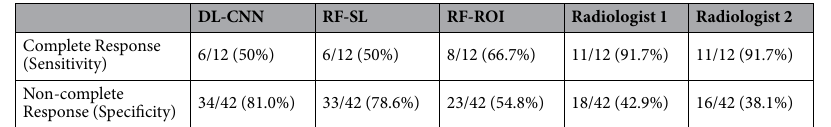
Table 2. Number of correctly predicted bladder cancer treatment response assessment of the test set at an operating point determined using the training set. DL-CNN: Deep-learning convolution neural network. RF- SL: Radiomics features extracted from segmented lesions. RF-ROI: Radiomics features extracted from pre- and post-treatment paired